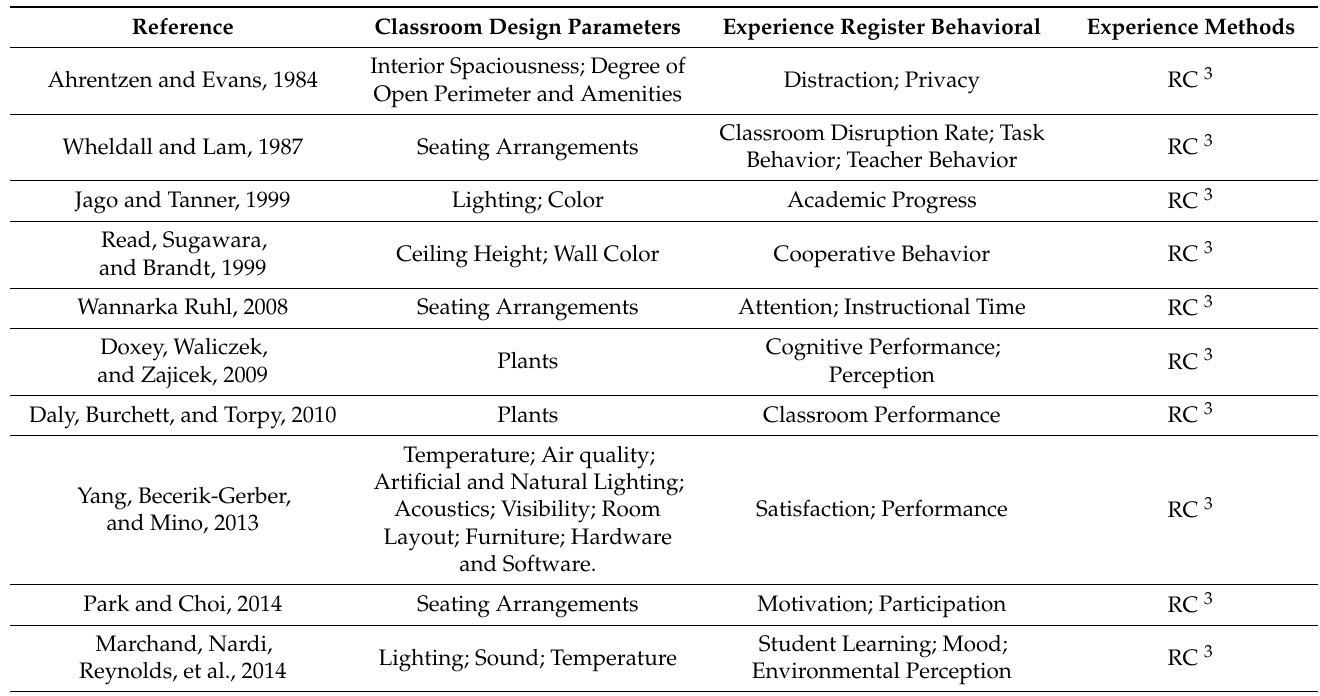
Table 1. Summary of studies of human behavior in